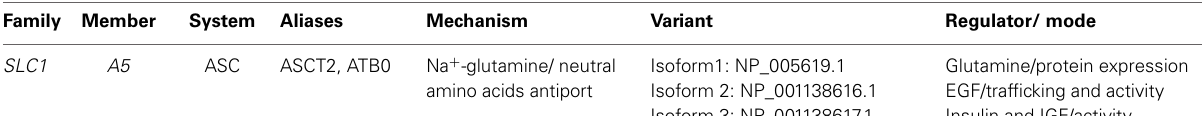
Table 1 | The basic characteristics of the glutamine transporters.